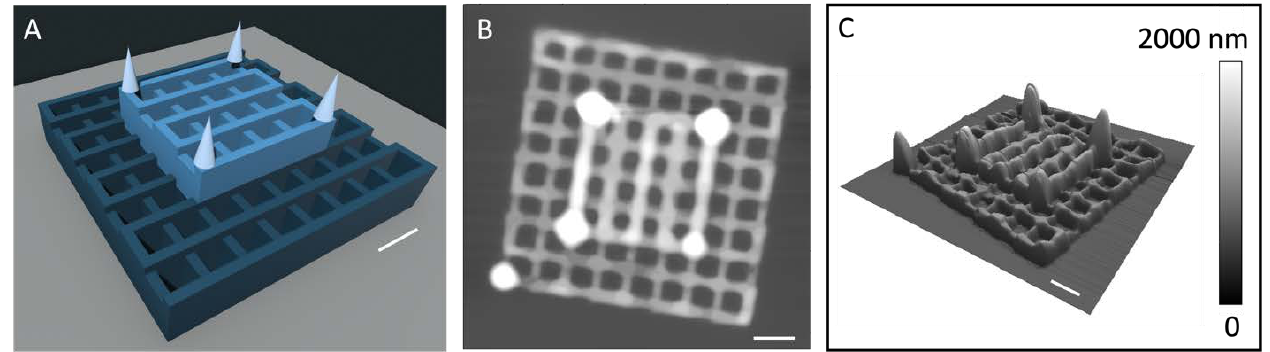
Figure 5. ( A ) Schematic diagram of a 3D structure used to 3D-print POPC. ( B ) Topographic AFM image of 3D POPC structure constructed following the design in ( A ). ( C ) A 3D display of the AFM image shown in ( B ). Scale bars = 5 µm.